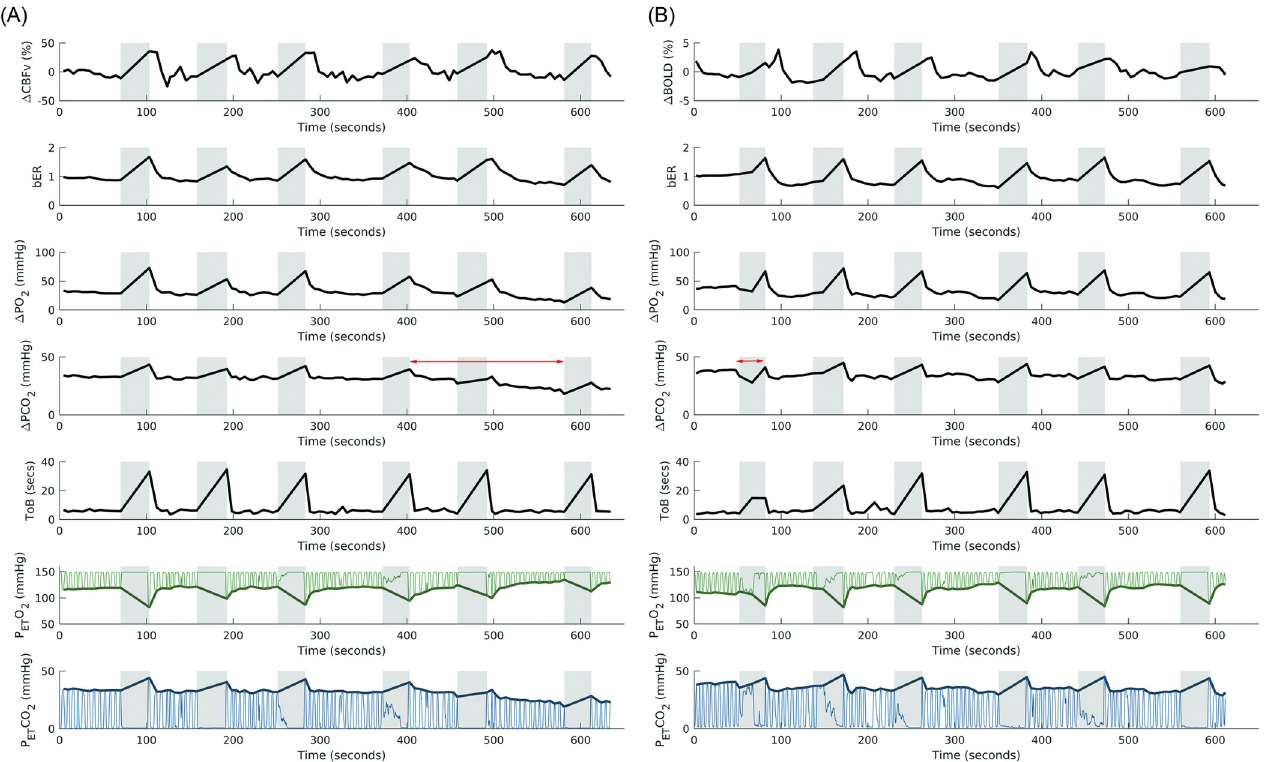
Fig 2. Time series of cerebral hemodynamic responses and RGE metrics in a representative subject under breath hold challenge. (A) Time series of Δ CBFv in left MCA and physiological changes including breath-by-breath bER, Δ PO 2 , Δ PCO 2 , ToB, P ET O 2 and P ET CO 2 in a representative subject under breath hold challenge in TCD session. (B) Time series of Δ BOLD in left gray matter (LGM) and the corresponding physiological changes in the same representative subject under breath hold challenge in MRI session. Shaded areas represent breath hold periods. The time series of bER followed closely to the Δ CBFv and Δ BOLD changes, while Δ PCO 2 did not follow Δ CBFv and Δ BOLD changes some time during the challenges as indicated by two-headed arrows in red. Thin green lines represent partial pressure of O 2 , while the thin blue lines represent partial pressure of CO 2 . Thick green lines and thick blue lines represent P ET O 2 and P ET CO 2 respectively.